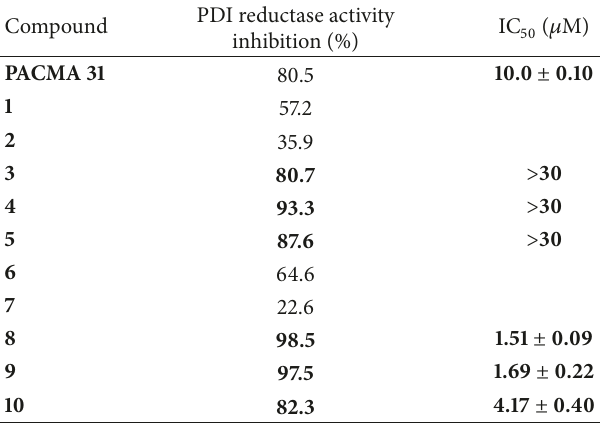
Table 1: Inhibition of PDI reductase activity (expressed in %) by the synthesized compounds and IC 50 values of the most potent